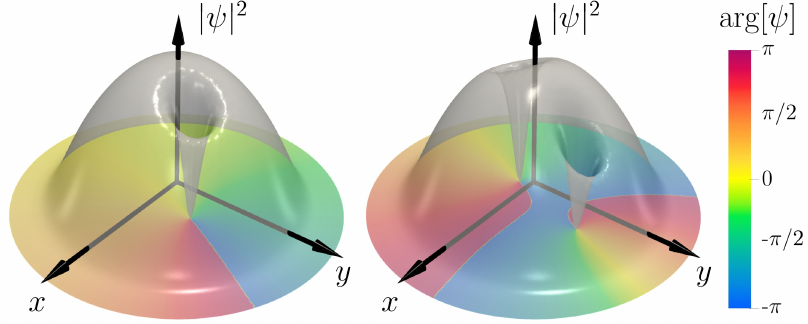
Figure 1 . Examples of asymmetric vortex configurations of a Bose-Einstein condensate in an axially symmetric harmonic trap. The elevation of the semitransparent surface stems for the condensate density | ψ | 2 , while the coloring projected onto the xy -plane indicates the value of the phase arg[ ψ ] of the macroscopic wave function. The examples shown are minima of the two dimensional Gross- Pitaevskii free energy (2.2), with non-integer values of the angular momentum (2.3) L z = 0 . 80 (left panel) and L z = 1 . 48 (right panel). The vortices precess around the trap center in accordance with the time dependent Gross-Pitaevskii equation